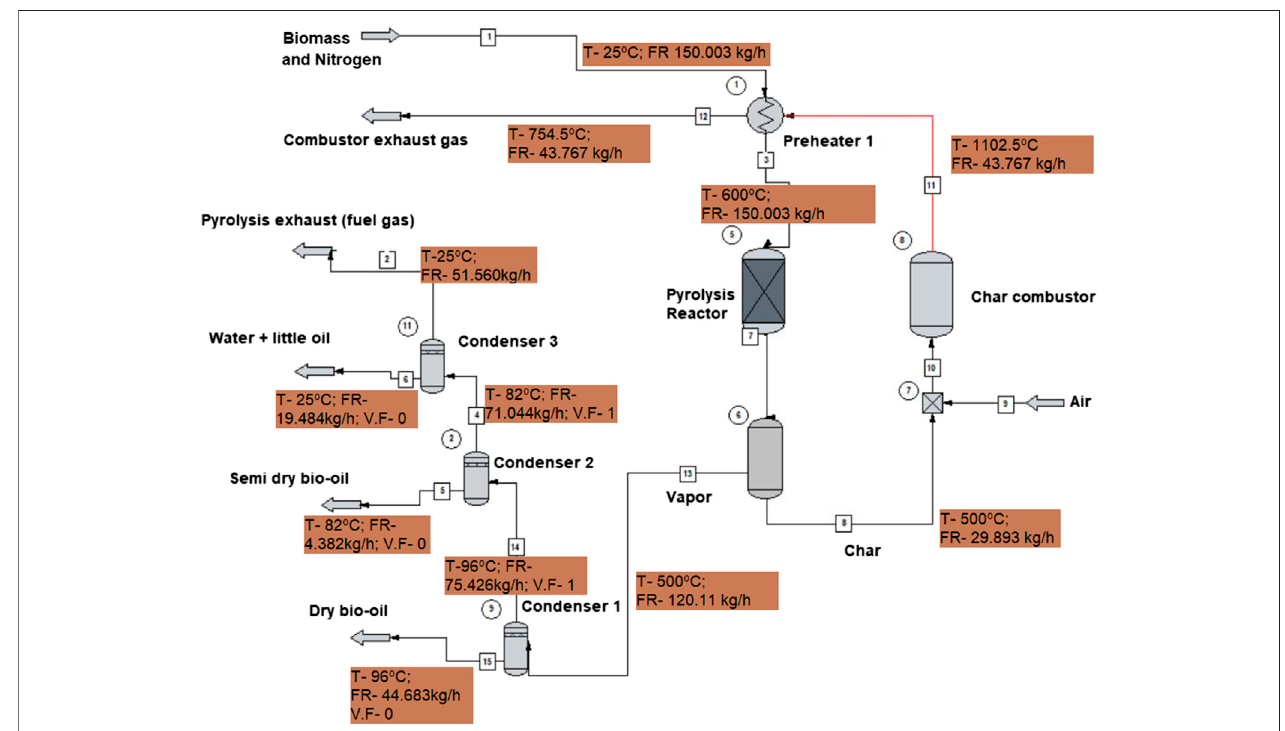
FIGURE 2 | The ChemCAD fl ow